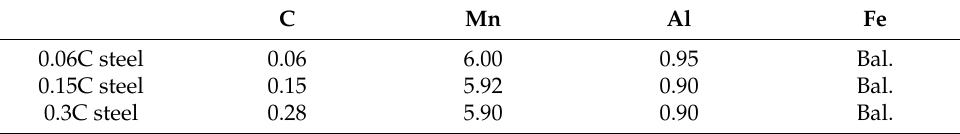
Table 1. The chemical compositions of the experimental steels (mass, %). C Mn Al